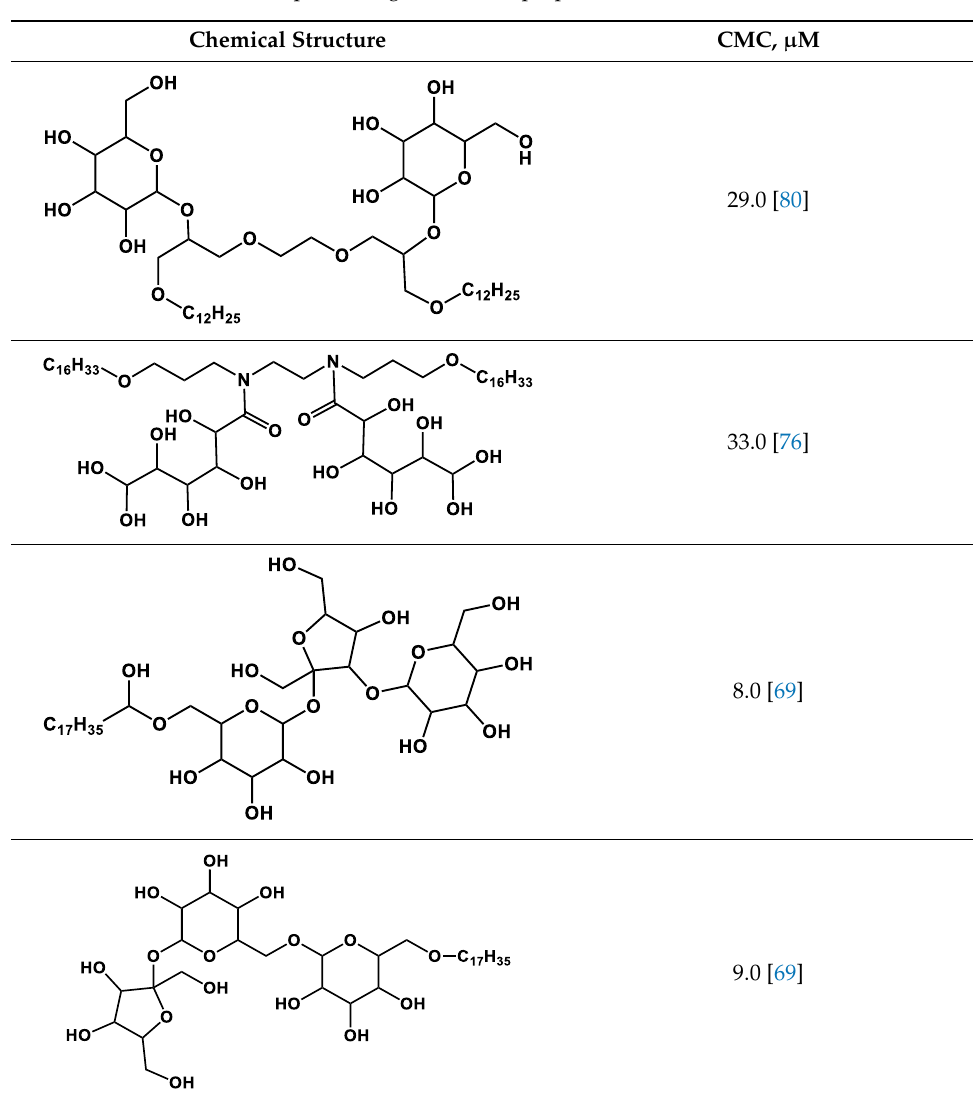
Table 2. Several examples of sugar-based amphiphiles with the lowest CMC values.